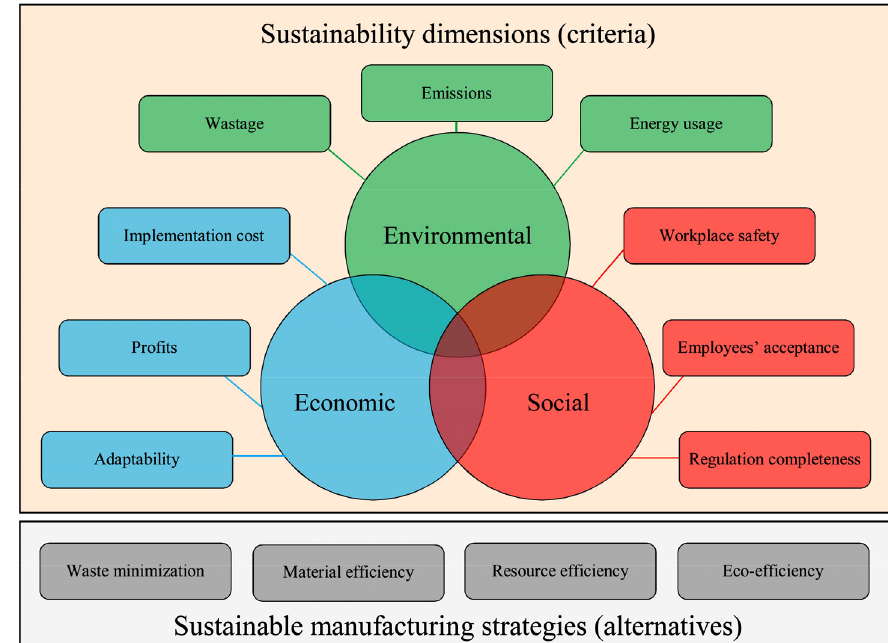
Figure 3. The structure of the